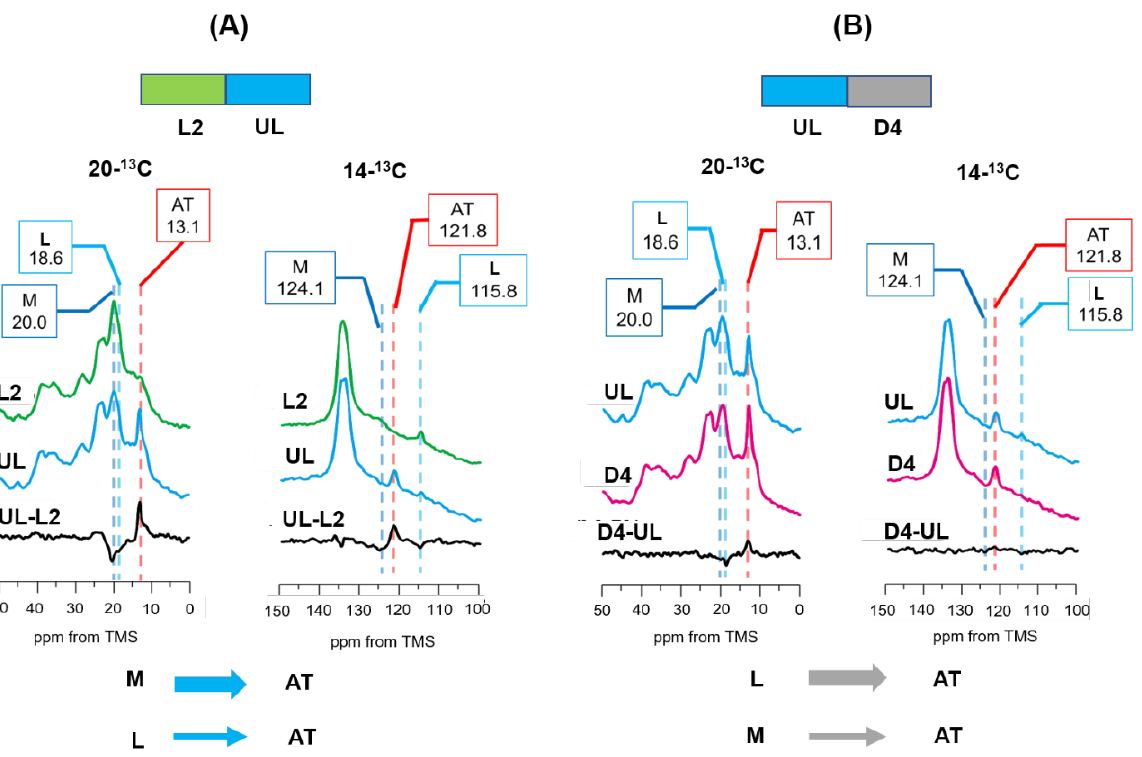
Figure 7. ( A ) Photoreaction pathway of [20- 13 C, 14- 13 C]retinal-D96N-BR under UV light (365 nm) illumination after green light illumination at − 30 ◦ C. 13 C CP-MAS NMR spectra were recorded under green light (L2; 20- 13 C and 14- 13 C) and then under UV light (UL; 20- 13 C and 14- 13 C), and the difference in spectra between UL and L2 (UL-L2) indicated that the M-intermediate changed more significantly to the AT state compared to the L intermediate. ( B ) Photoreaction pathway of [20- 13 C, 14- 13 C]retinal-D96N-BR in the dark after UV light illumination at − 30 ◦ C. 13 C CP-MAS NMR spectra were recorded under UV light (UL; 20- 13 C and 14- 13 C) and then in the dark (D4; 20- 13 C and 14- 13 C), and the difference in spectra between D4 and UL (D4-UL; 20- 13 C and 14- 13 C) indicated that the L intermediates changed to the AT state, and a small amount of the M-intermediate also changed to the AT state.